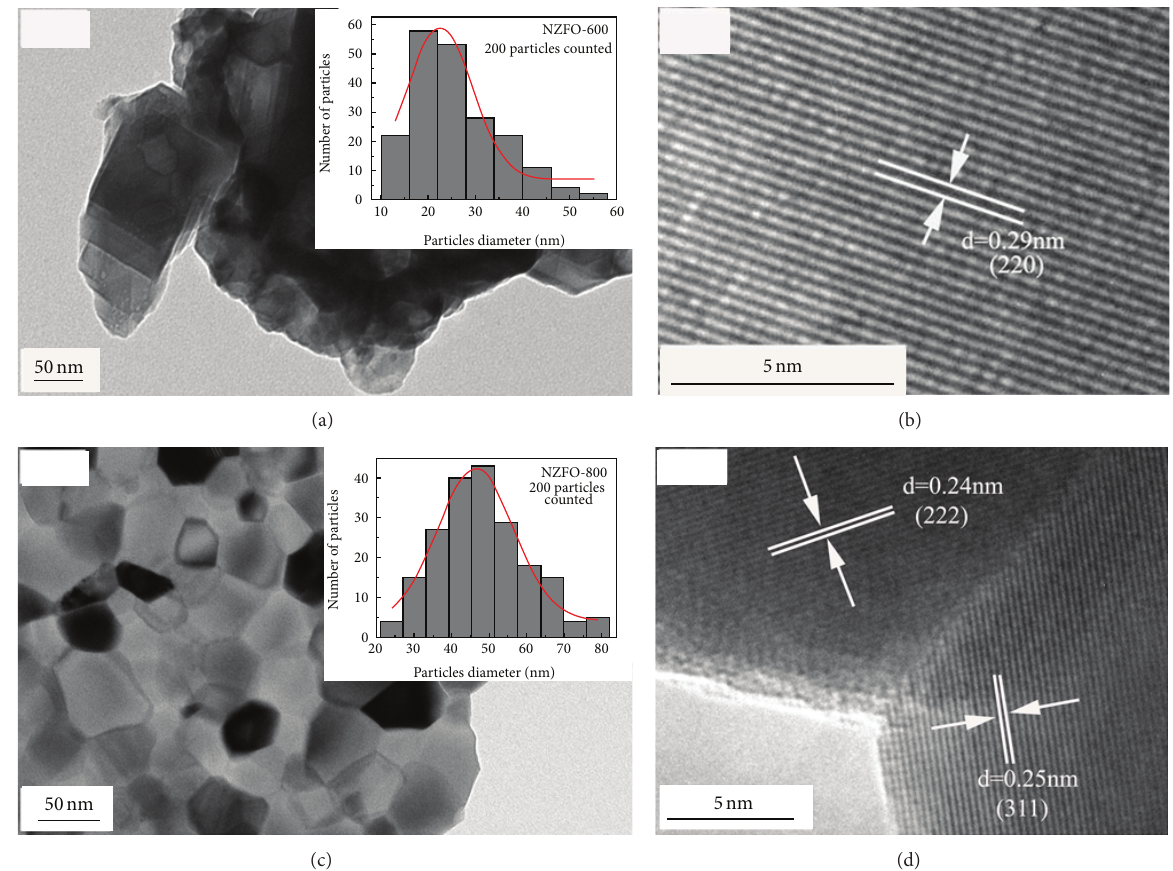
Figure 3: (a) TEM image of NZFO-600 ferrite: the inset is particle size distribution graph, (b) high magnification TEM image for NZFO-600 ferrite, (c) TEM image of NZFO-800 ferrite: the inset is particle size distribution graph, and (d) high magnification TEM image for NZFO-800